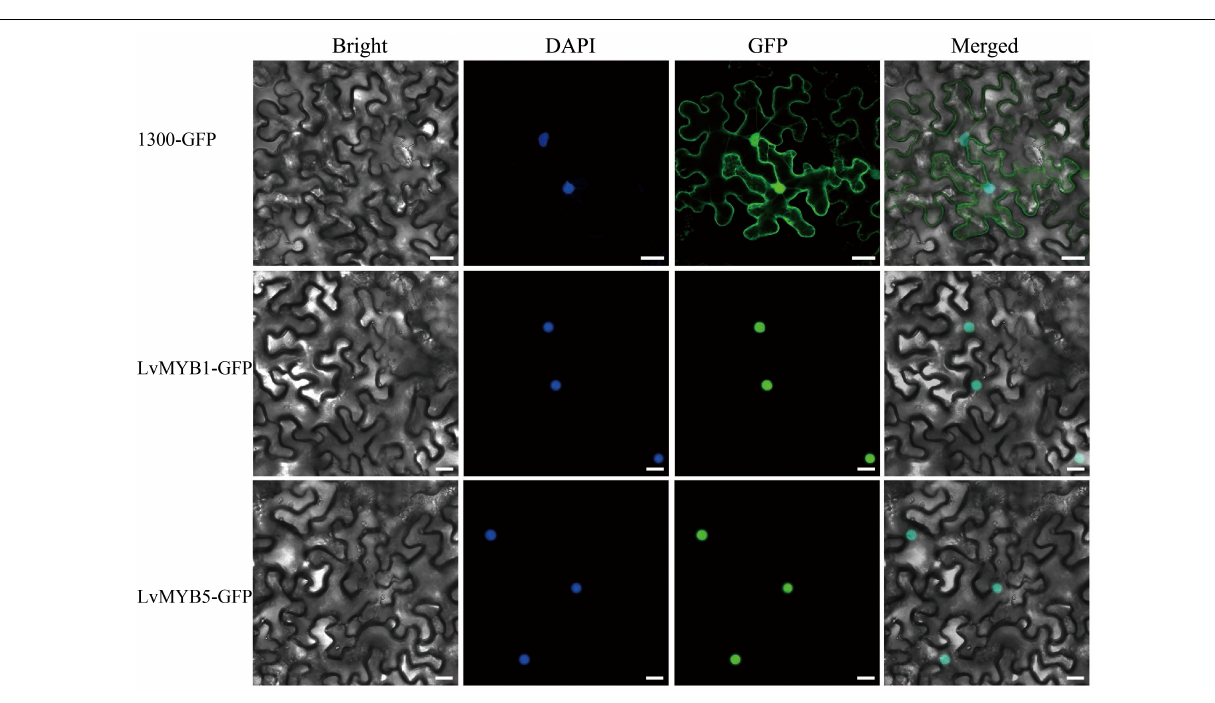
Frontiers in Plant Science |